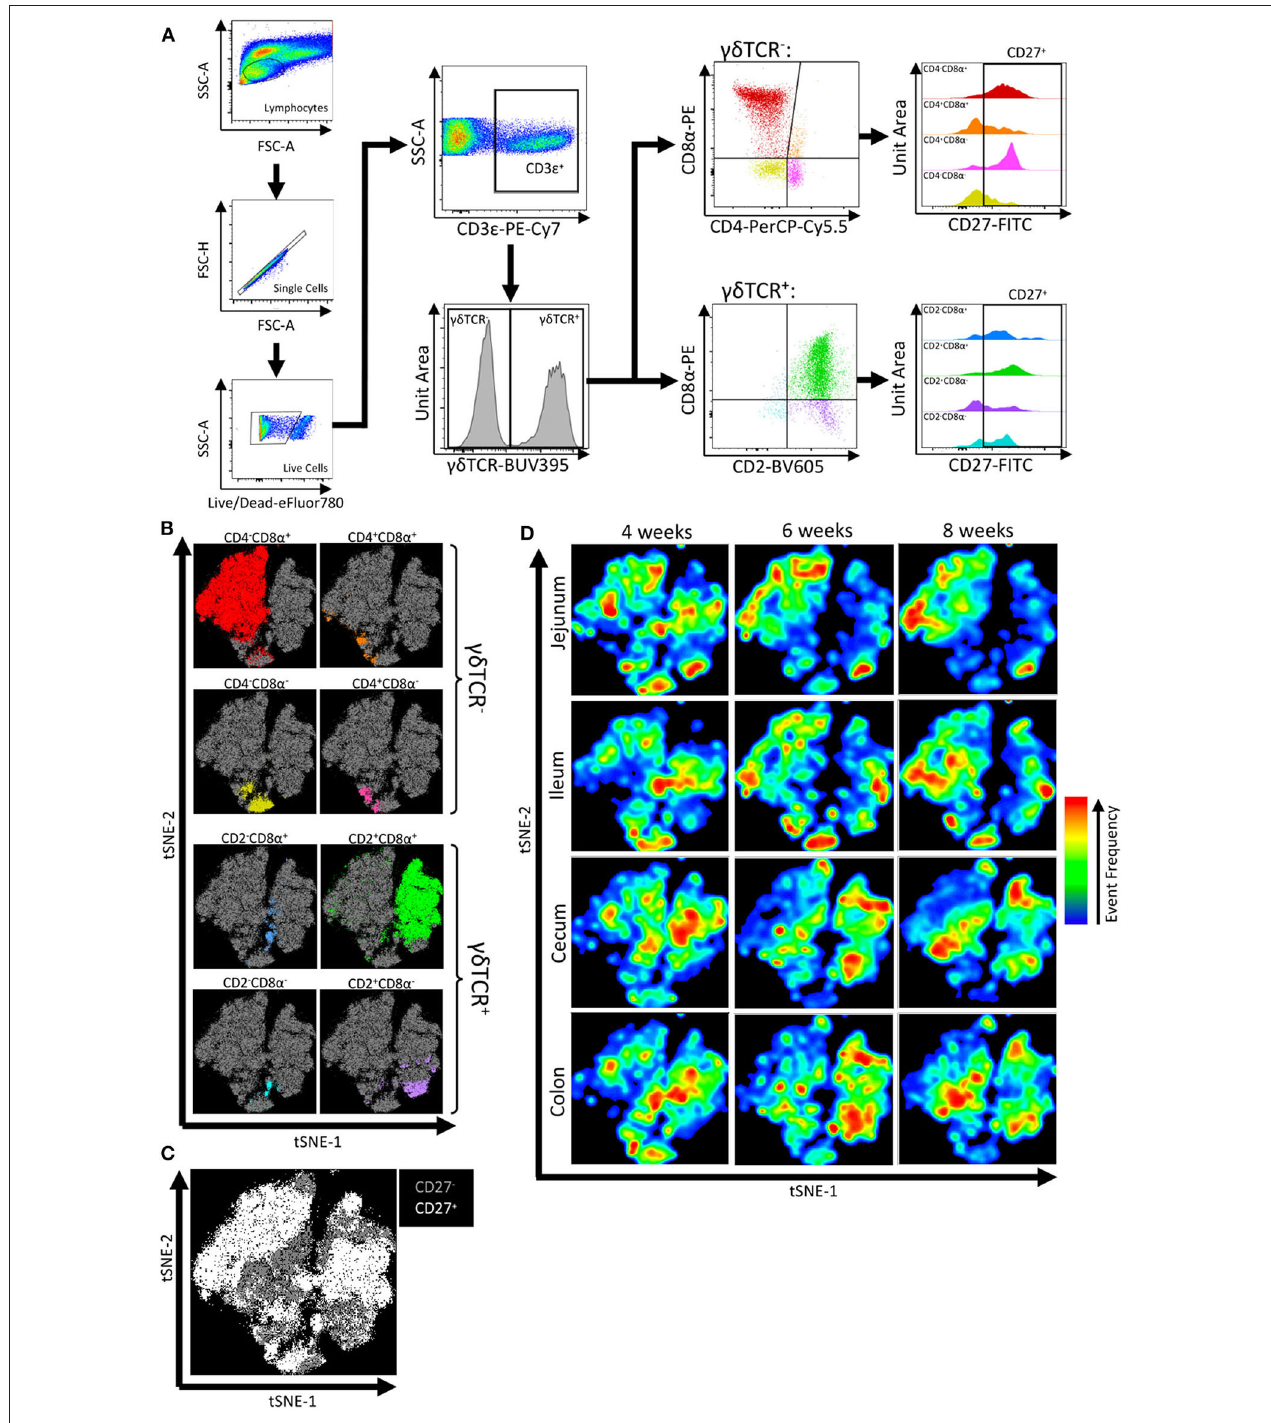
FIGURE 2 | Flow cytometry gating revealed IET populations and CD27 expression varied by intestinal location and age. (A) Gating strategy used to identify IET populations and subpopulations from flow cytometry data of epithelial-enriched samples. (B–D) t-SNE dimensional reduction of gated flow cytometry data from all samples to reveal clustering of αβ and γδ IET populations (B) , CD27 + and CD27 − expression (C) , and tissue and age-specific cell frequency distributions (D) . In (B,C) , individual points represent single cells. Plot axes indicate t-SNE dimensions. Cells highlighted in non-gray colors coordinate with corresponding αβ and γδ IET populations (B) or CD27 + classification (C) . In (D) , areas with more cells present are indicated by red, whereas areas with less cells present are indicated by blue. Subsets of total IETs were taken from each sample ( n = 990) to obtain equal cell numbers for each individual sample; an equal number of cells are present for each animal and combination of intestinal tissue and timepoint. Samples were taken from four animals per timepoint in each of two separate experiments ( n = 8 per timepoint; n = 24 total).